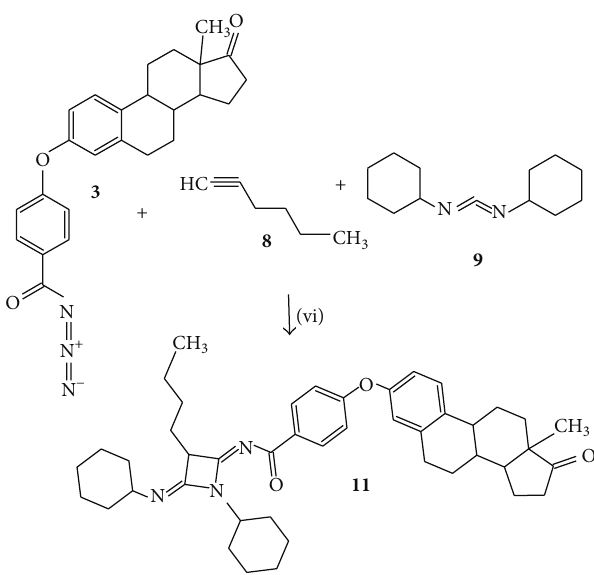
Figure 4: Synthesis of 𝑁 -(3-butyl-1-cyclohexyl-4-cyclohexylimino- azetidin-2-ylidene)-4-(13-methyl-17-oxo-7,8,9,11,12,13,14,15,16,17-dec- ahydro-6H-cyclopenta[a]phenanthren-3-yloxy)-benzamide ( 11 ). Reaction of 3 with 1-hexyne ( 8 ) and 𝑁 , 𝑁 󸀠 -Dicyclohexylcarbodi- imide ( 9 ) to form 11 . (vi) = methanol/dimethyl